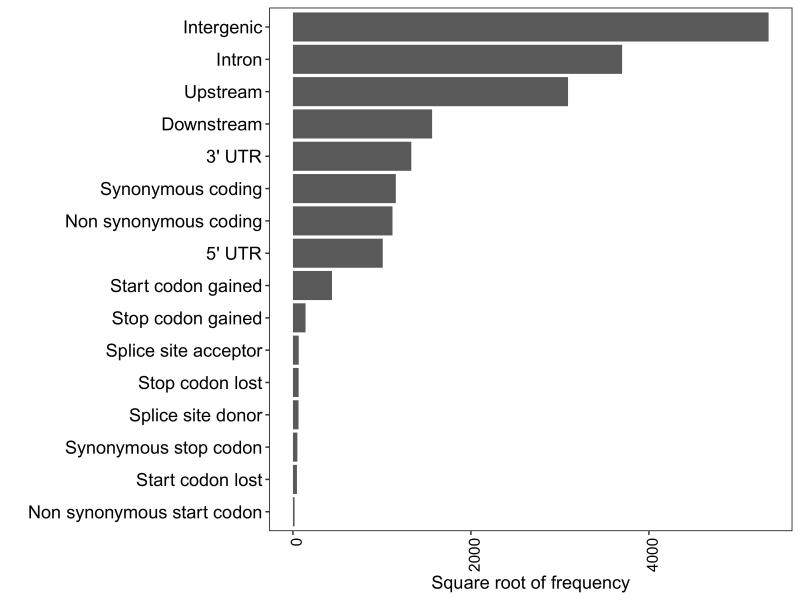
The frequency of SNP sites with varying effects to the genomic structure of the maize reference genome.